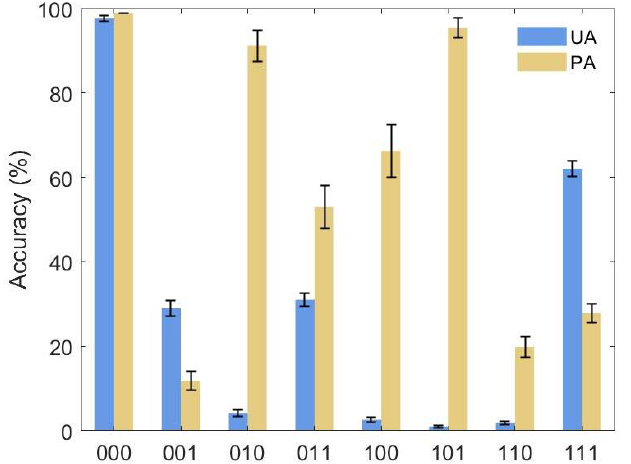
Figure 11. Accuracy estimation of the three phases of urban land for the change and no-change types (000–111 denote the urban land change and no-change types corresponding to Table 5). OA = 96.1 ± 0.25%.